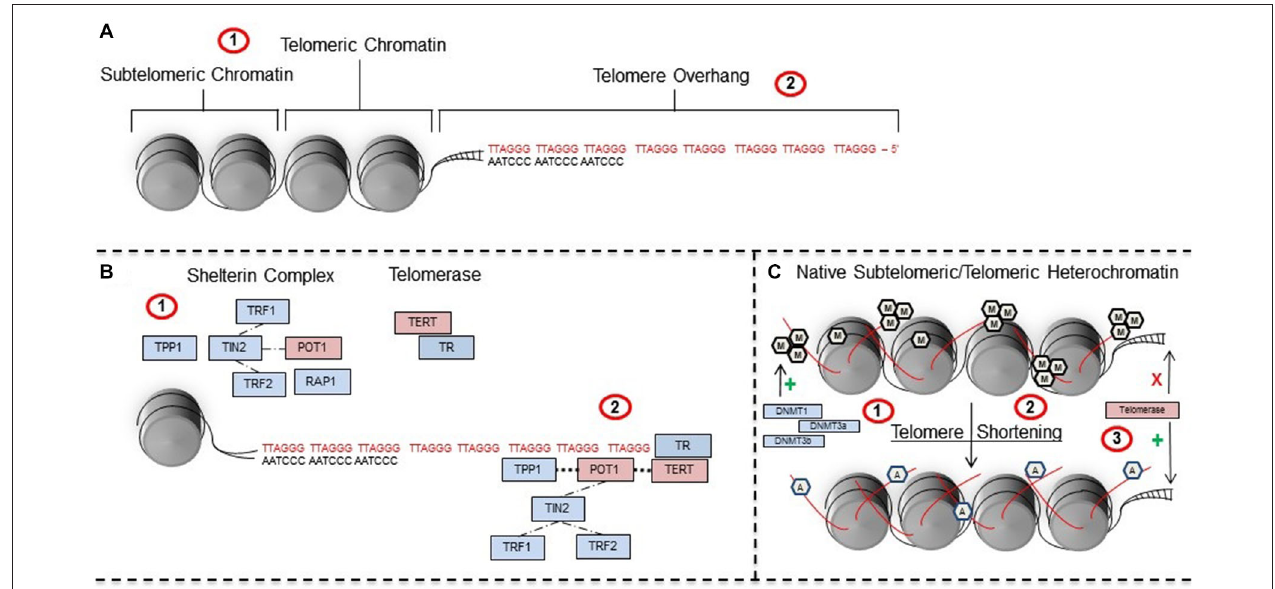
regulated and maintained by key DNA methyltransferases including DNMT1, DNA methyltransferase 3a (DNMT3a), and DNMT3b. However, (C2) telomere shortening induces a shift to a euchromatic state involving increased acetylation and decreased methylation which (C3) facilitates the recruitment of telomerase to telomere ends. Abbreviations: TTAGGG-repeat binding factor 1 (TRF1), TTAGGG-repeat binding factor 2 (TRF2), collective acronym of previous labels TINT1, PTOP, and PIP1 (TPP1), TRF-1 interacting nuclear protein/factor 2 (TIN2), (RAP1), protection of telomeres 1 (POT1), telomerase reverse transcriptase (TERT), TR, methyl group (pentagonal M), acetyl group (pentagonal